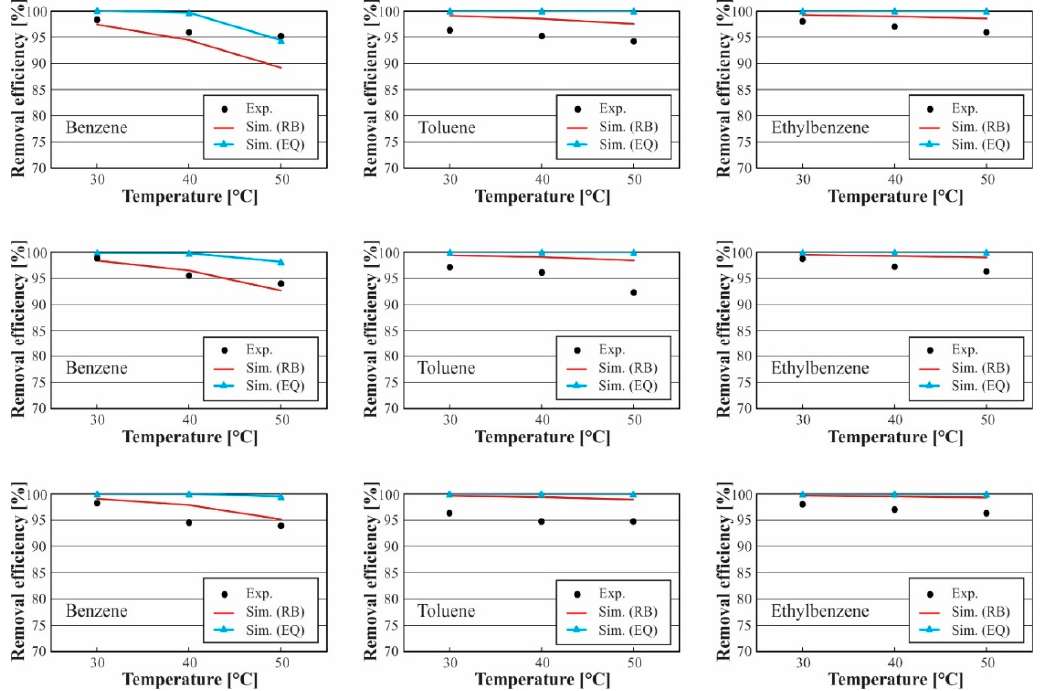
Figure 8. Effect of solvent temperature on the removal efficiency of tar components at a bed height of Figure 8. E ff ect of solvent temperature on the removal e ffi ciency of tar components at a bed 0.8 m and different solvent volumetric flow rates 53 mL/min (above), 63 mL/min (middle), 73 mL/min height of 0.8 m and di ff erent solvent volumetric flow rates 53 mL / min ( above ), 63 mL / min ( middle ), (below). 73 mL / min ( below ). Appl. Sci. 2020 , 10 , x FOR PEER REVIEW